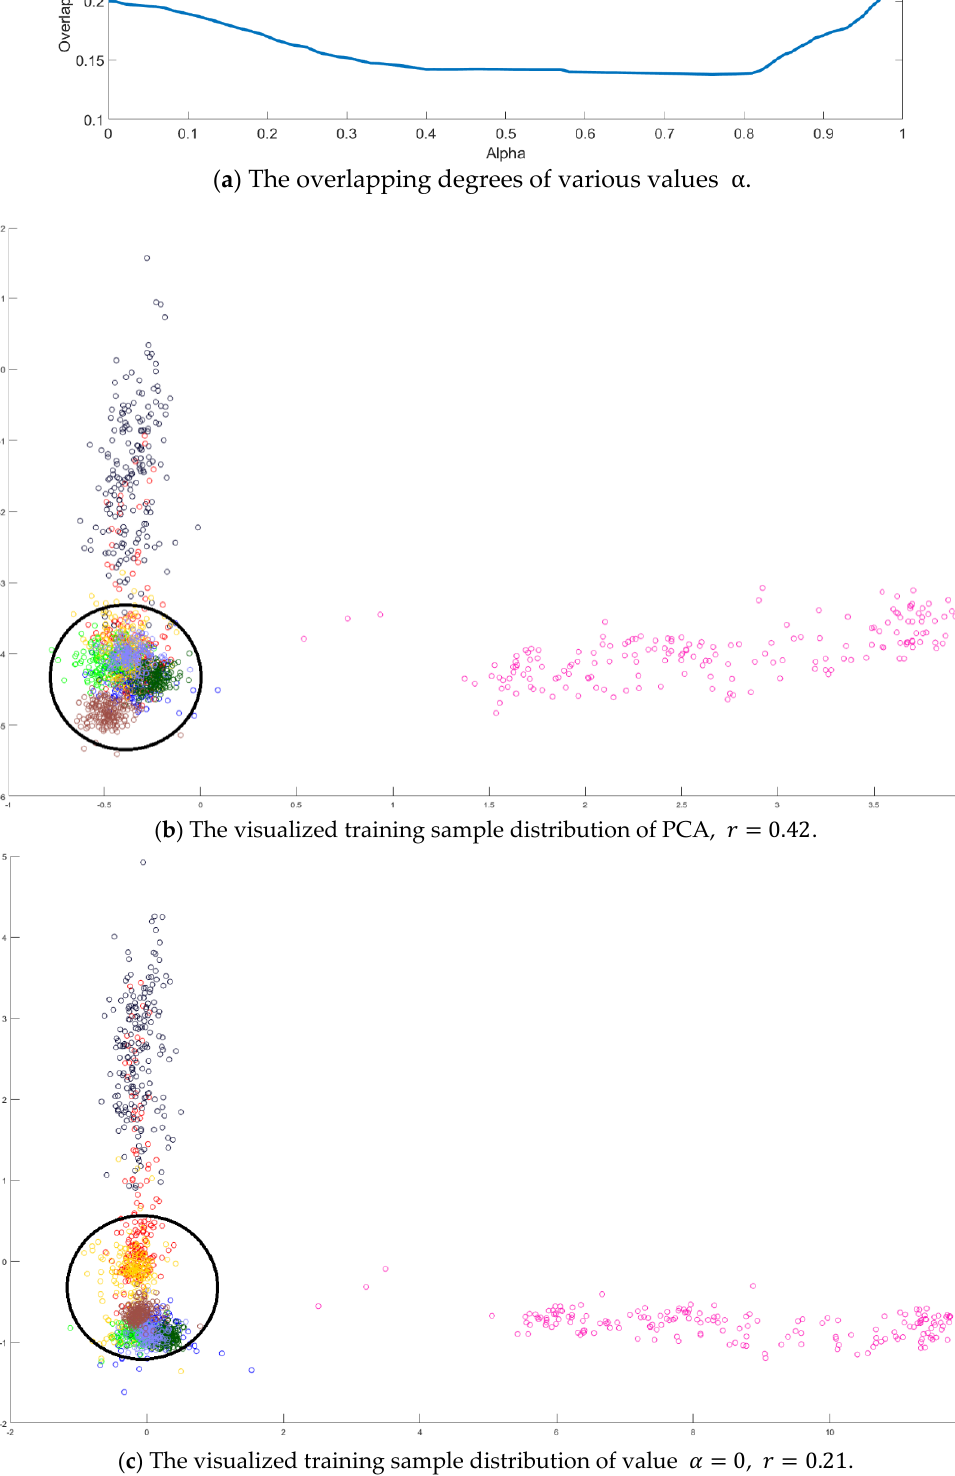
( c ) The visualized training sample distribution of value 𝛼 = 0 , 𝑟 = 0.21 . Figure 7. Cont